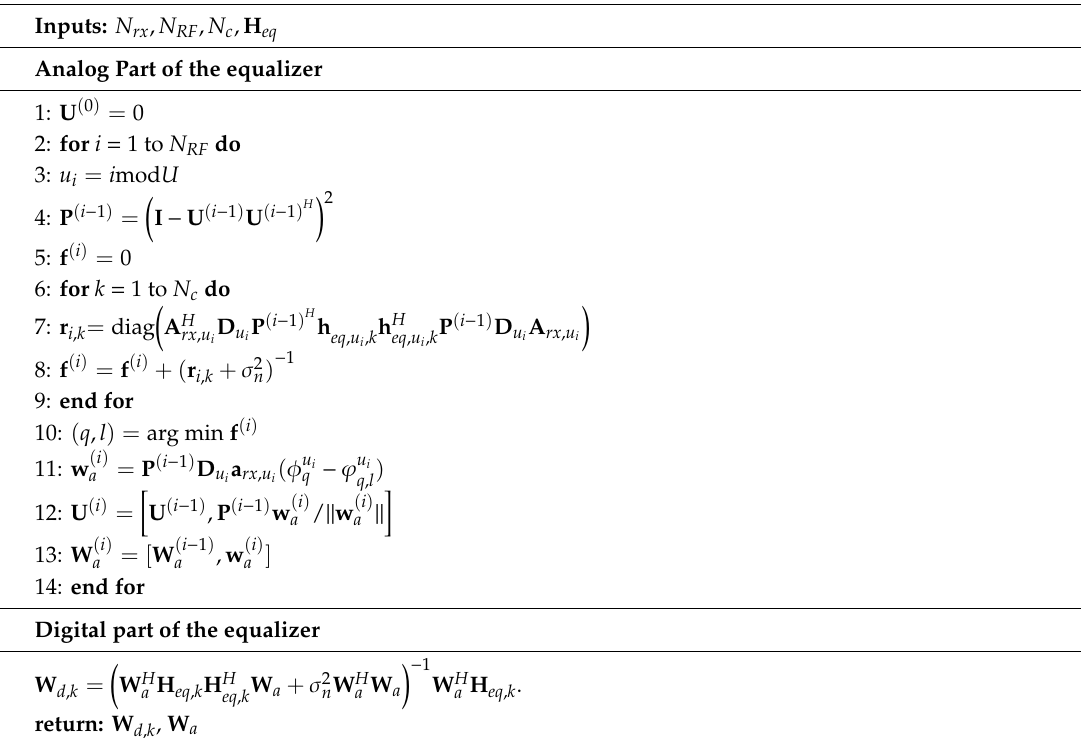
Algorithm 1: The proposed analog–digital multi-user linear equalizer algorithm for sub-connected